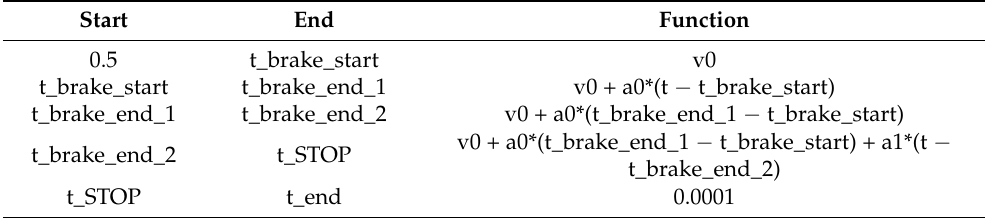
Table 5. Definition of the velocities for the COMSOL simulation as functions.